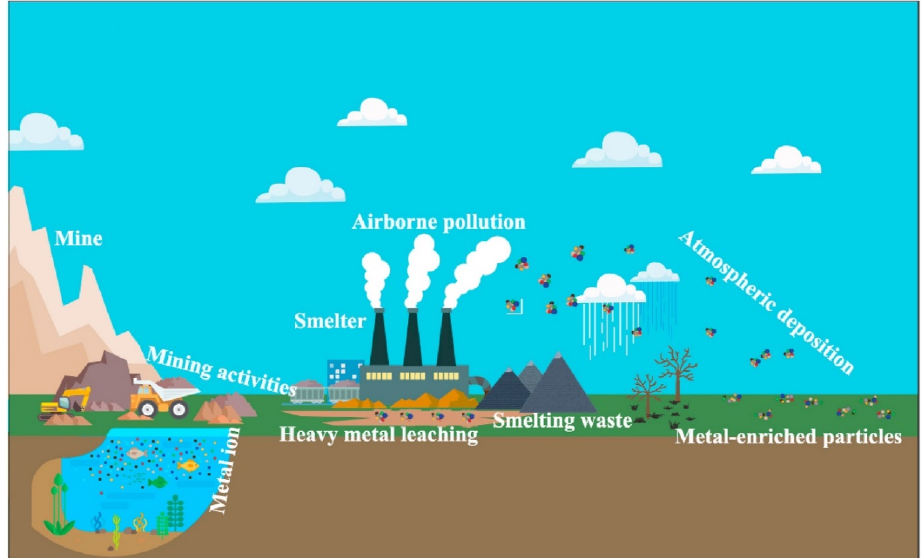
Figure 1. Schematic illustrating pollution sources of heavy metals in smelter polluted soils. Reprinted from [103], Copyright (2021), with permission from Elsevier.